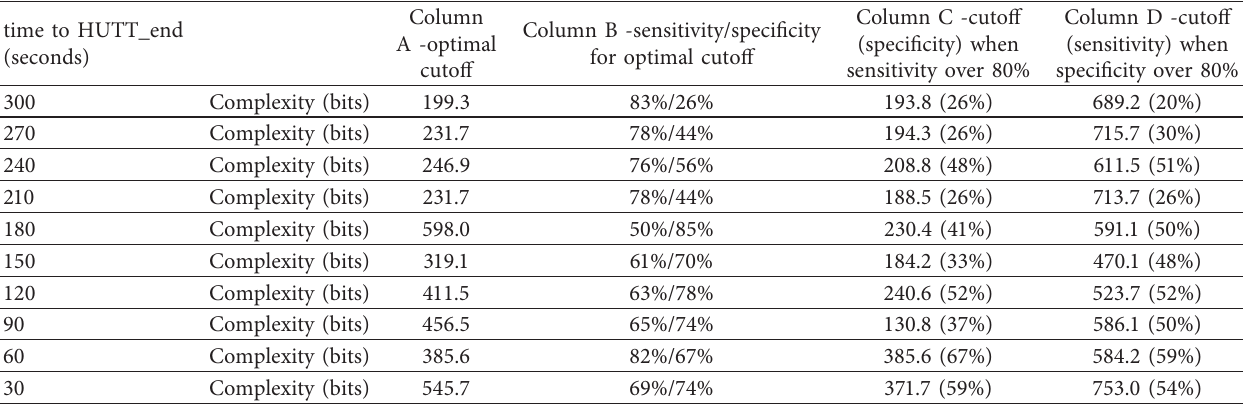
Table 4: The optimal cutoffs of complexity (column A) within last 300 seconds before the termination of HUTT, corresponding sensitivity and specificity (column B), specificity in term sensitivity over 80% (column C), and sensitivity in term specificity over 80% (column